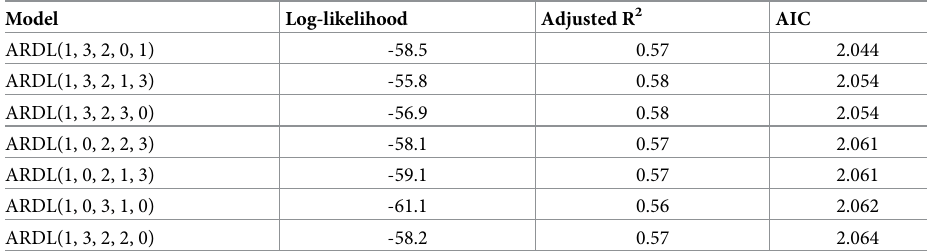
Table 5. Best fitted ARDL models with minimum AIC values.